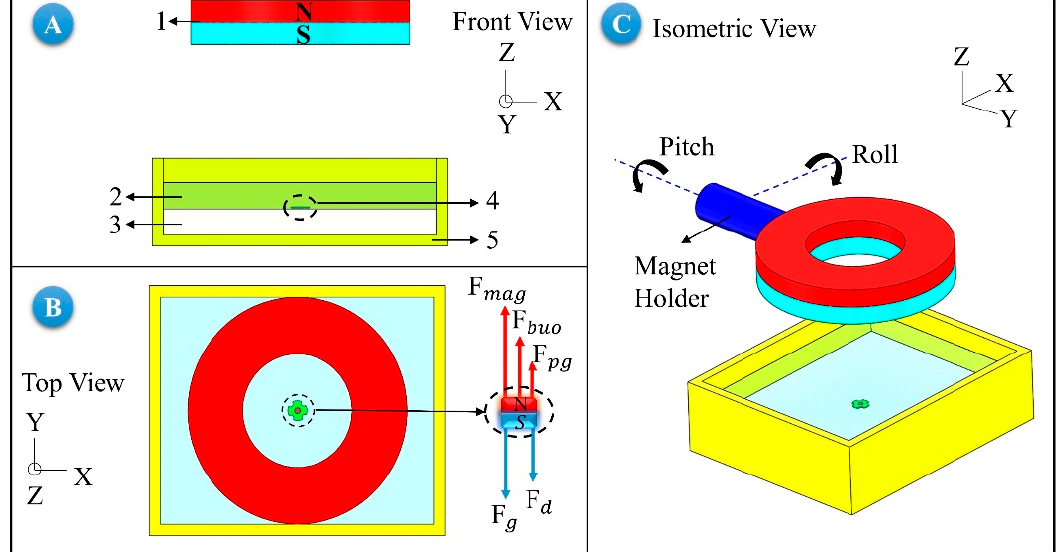
Figure 4. Diagram of magnetic levitation system used in experiments. Numbers represent part names. ( A ) shows vertical alignment of microrobot and lifter-magnet; ( B ) shows forces exerted on microrobot, which is aligned with lifter-magnet; and ( C ) illustrates isometric view of the whole experimental setup.